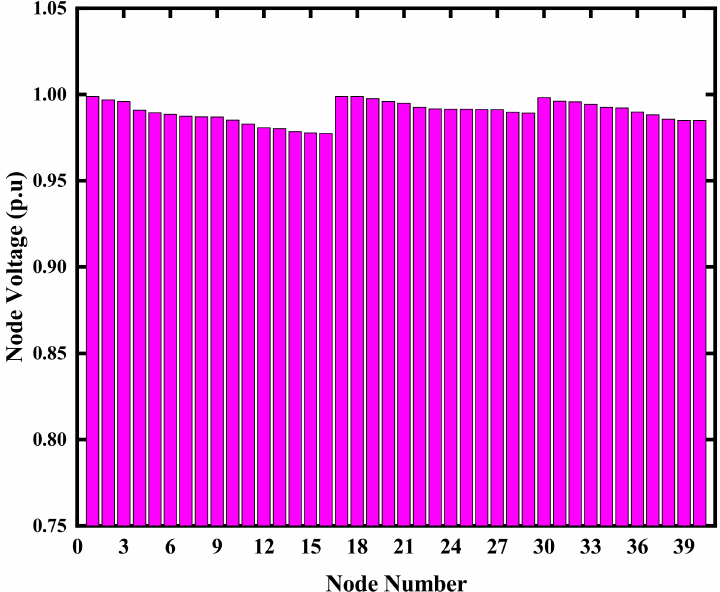
Figure 5. Node voltages without DG.